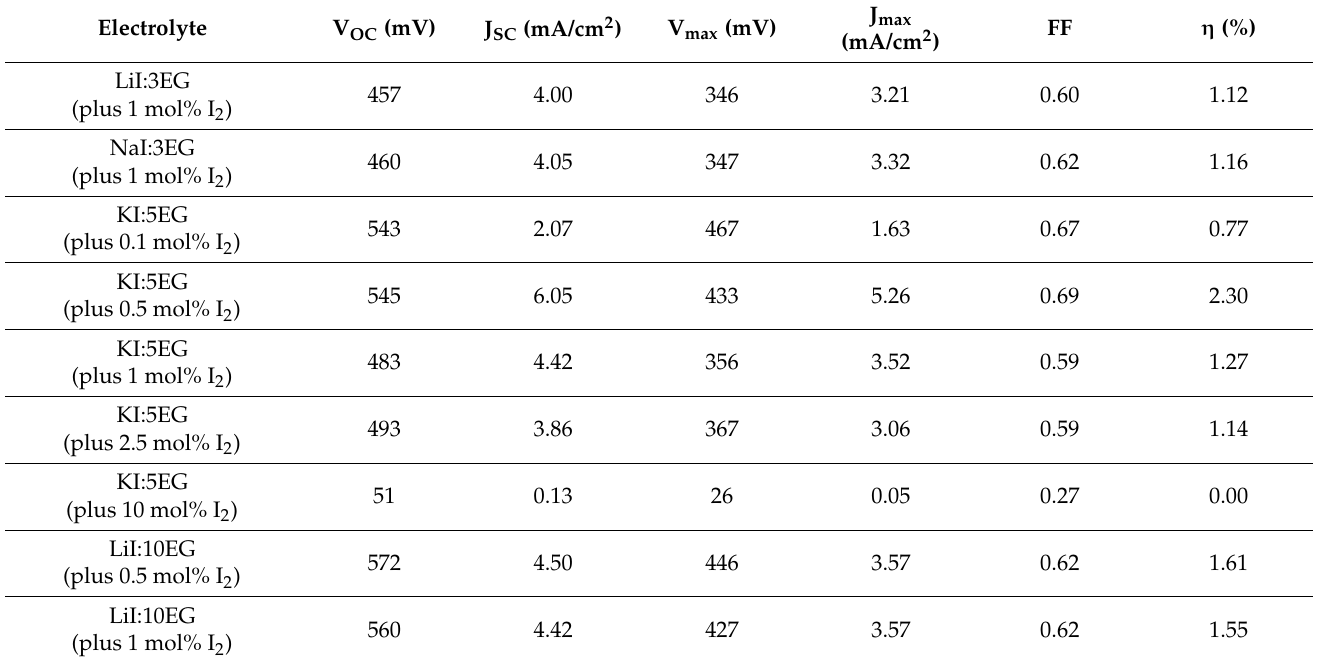
Table 1. Photovoltaic performance parameters of DSSCs based on dye N719 for the different alkali eutectic mixtures as electrolyte, under 100 mW · cm − 2 simulated AM 1.5 illumination. ( The results presented are for the best performing cell ). Electrolyte V OC (mV) J SC (mA/cm 2 ) V max